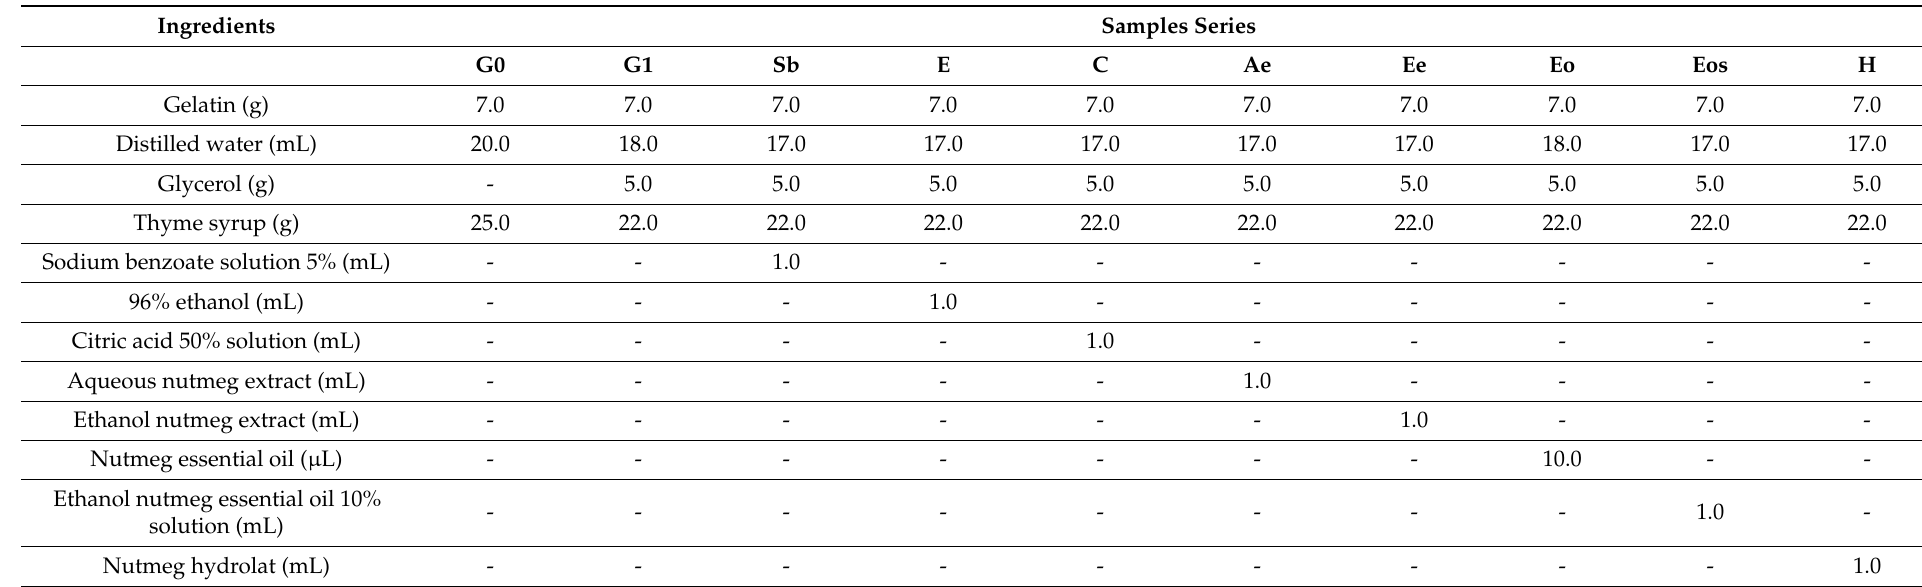
Table 1. Chewable gel tablets’